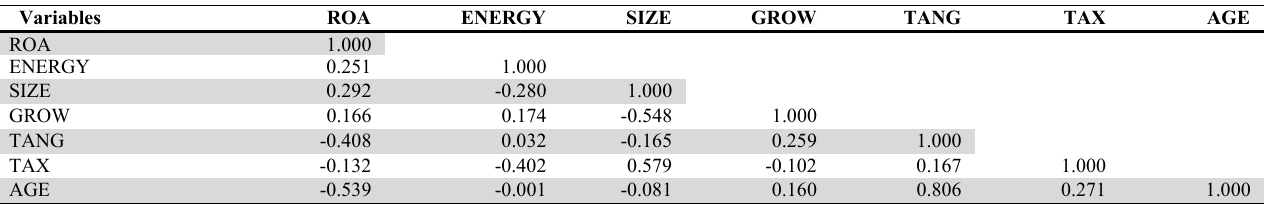
Correlation matrix